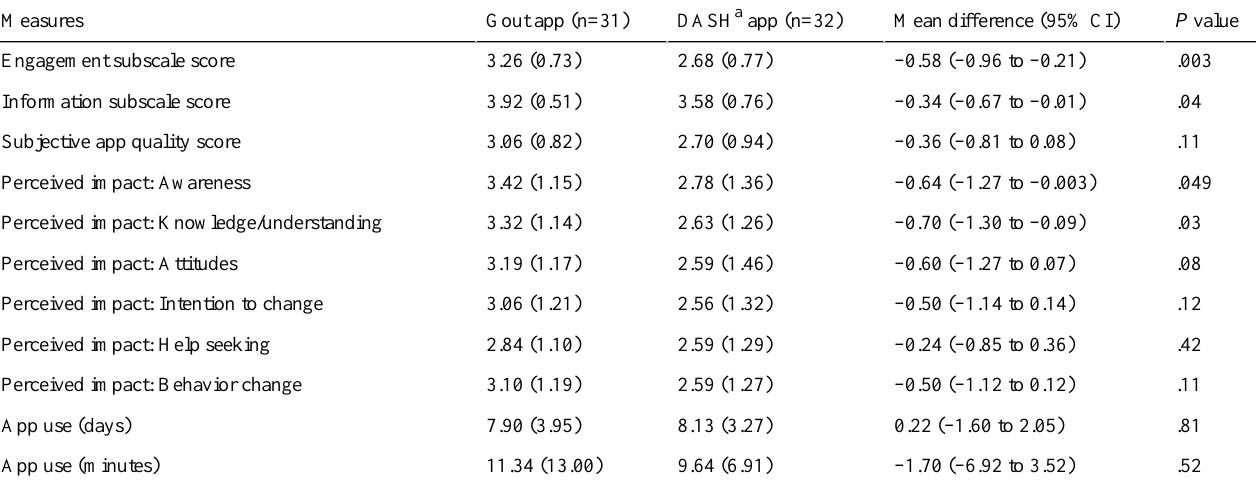
Table 3. Differences in user engagement between app groups postintervention measured by the user version of the Mobile Application Rating Scale (score range: